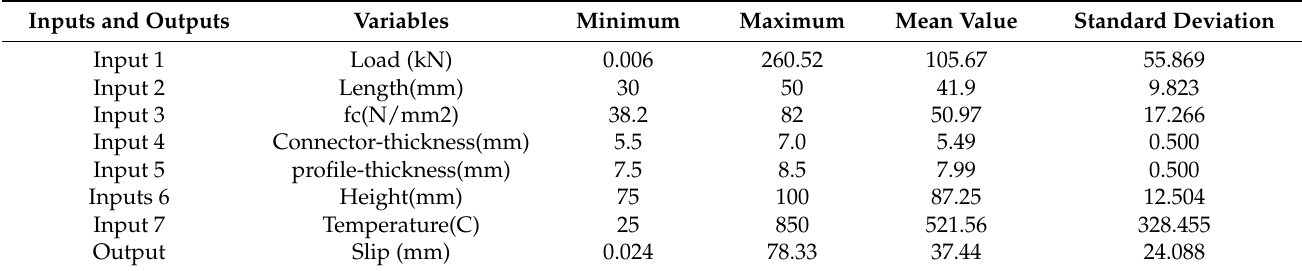
Table 3. Details of the input and output variables.